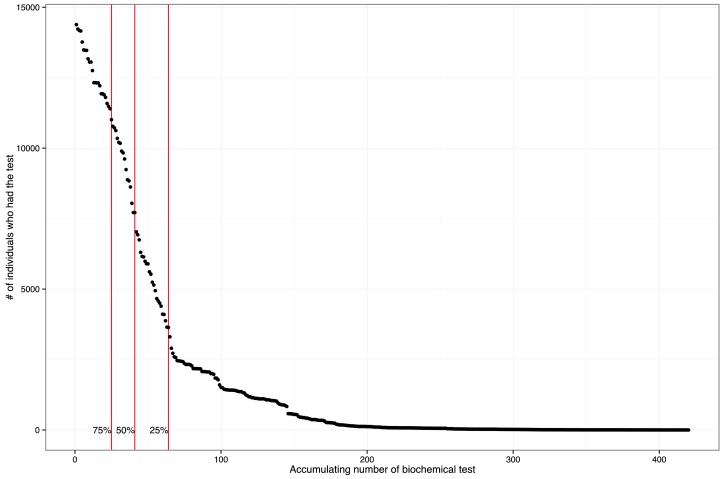
Distribution of patients per physiological and biochemical test.Number of unique patients who have had a given biochemical test. Shows that the majority of biochemical tests were performed on only a few individuals. The red lines mark the 25, 50, and 75% of individuals in the cohort: 26, 41, 64, and 356 biochemical tests were taken in 75%, 50%, 25%, and less than 25% of the cohort, respectively.